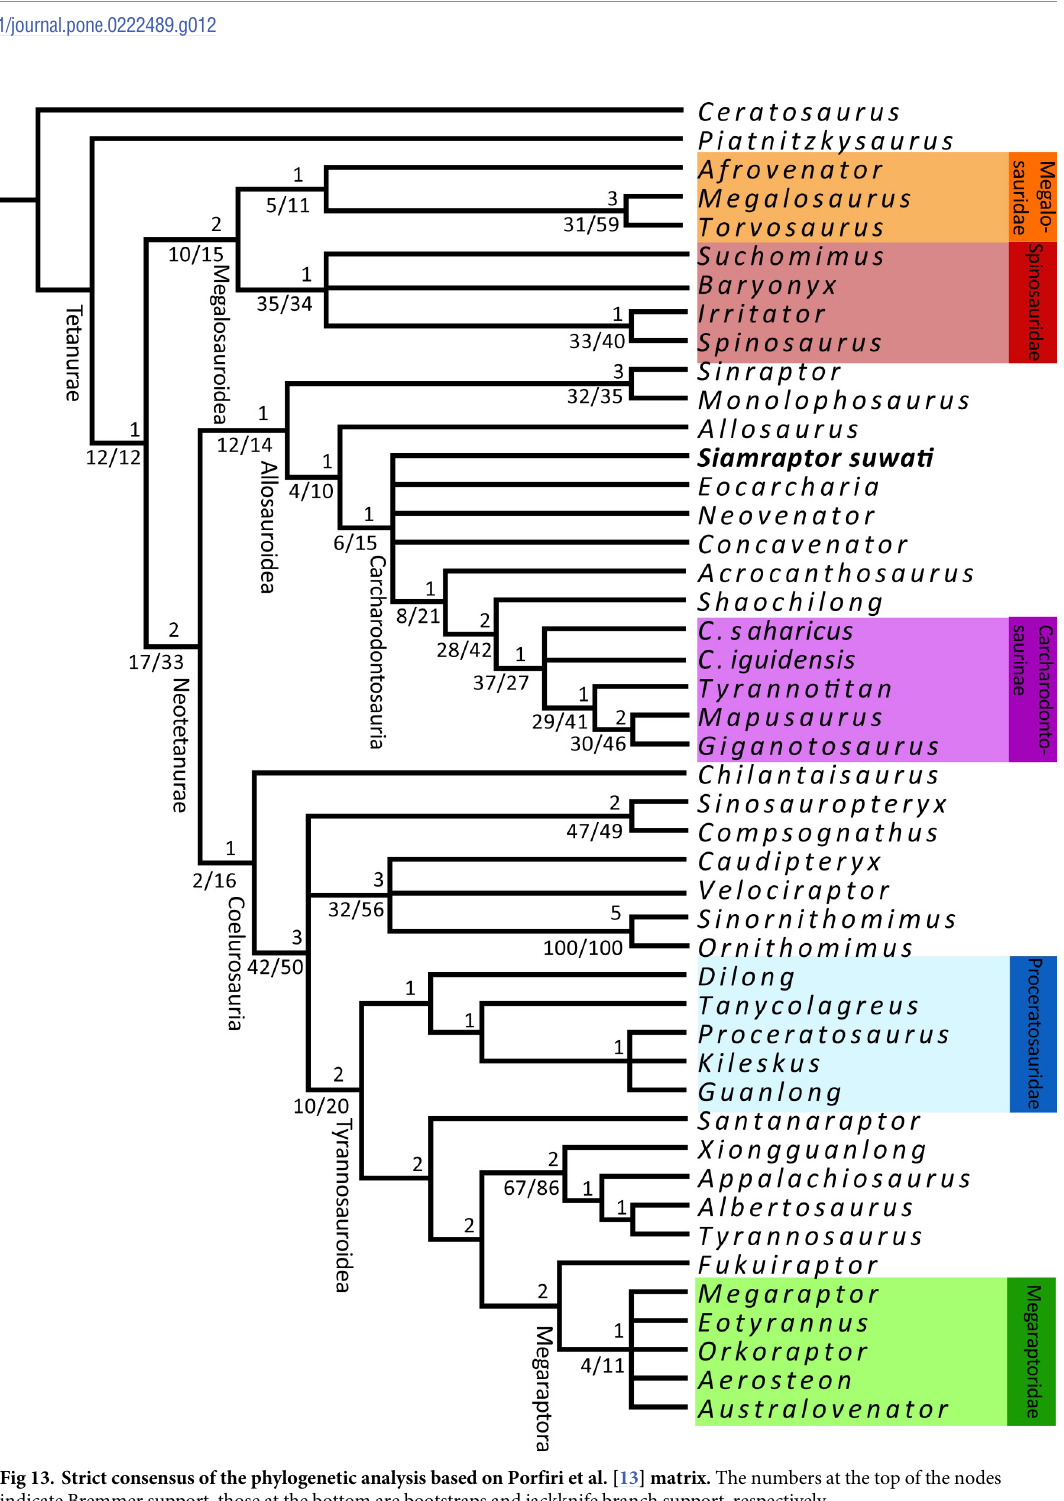
Fig 13. Strict consensus of the phylogenetic analysis based on Porfiri et al. [13] matrix. The numbers at the top of the nodes indicate Bremmer support, those at the bottom are bootstraps and jackknife branch support, respectively.